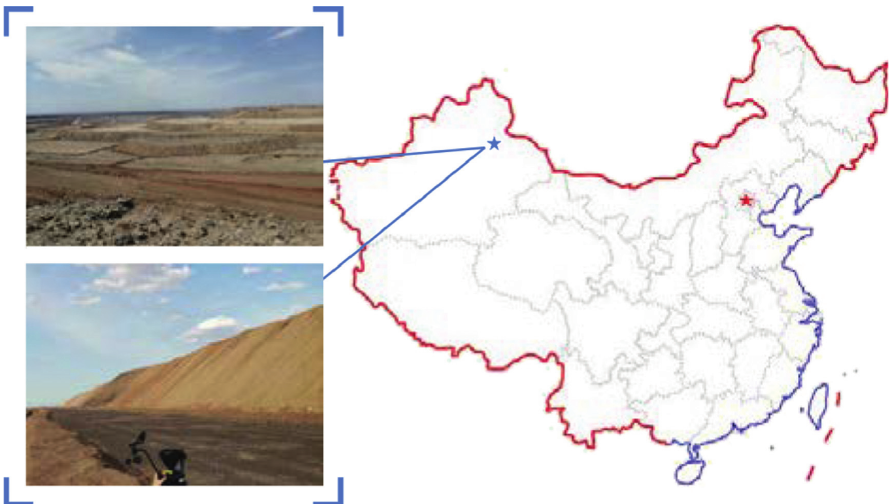
Figure 2: The location and external dump site of Hongshaquan open-pit mine.